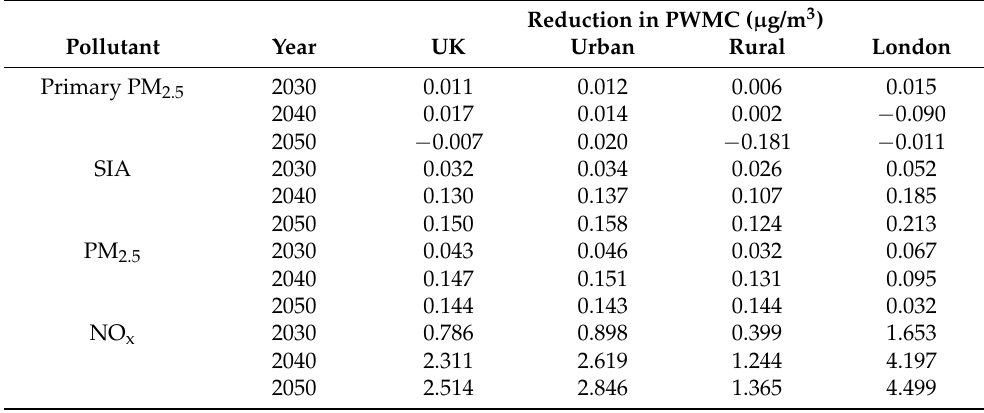
Table 4. Reduction in PWMC by UK region for primary PM 2.5 , SIAs, PM 2.5 (primary and secondary), and NO x , for the EV scenario compared to the 2030 Euro 6 RDE scenario. Reduction in PWMC ( µ g/m 3 ) Pollutant Year UK Urban Rural London